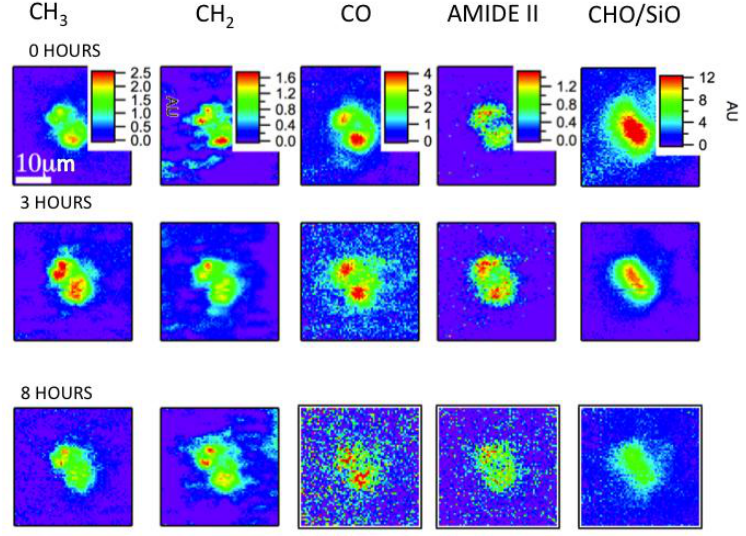
Figure 6. Temporally resolved series of IR images showing distributions of biochemically important functional groups and time dependent changes in the concentrations of several biochemical functional groups for a Thalassiosira weissflogii maintained in the flow cell. The images are obtained from data sets collected at 1, 3 and 8 h after exposure to medium containing a high concentration (5000 ppm) of CO . The images are displayed on a rainbow 2 scale, with the red corresponding to the highest detected quantity of the functional